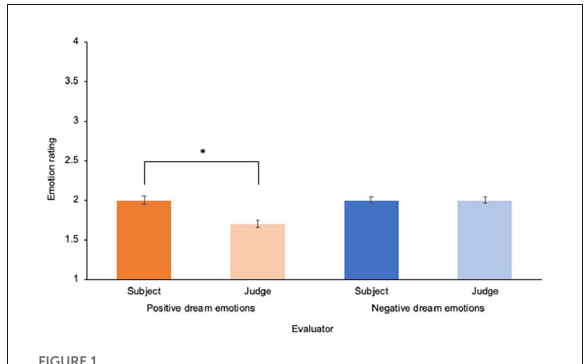
FIGURE1 Mean differences in subject’s and a judge’s evaluations of positive and negative emotions in dreams. N = 345 dreams, ∗ p < 0.05. Error bars represent standard error of the